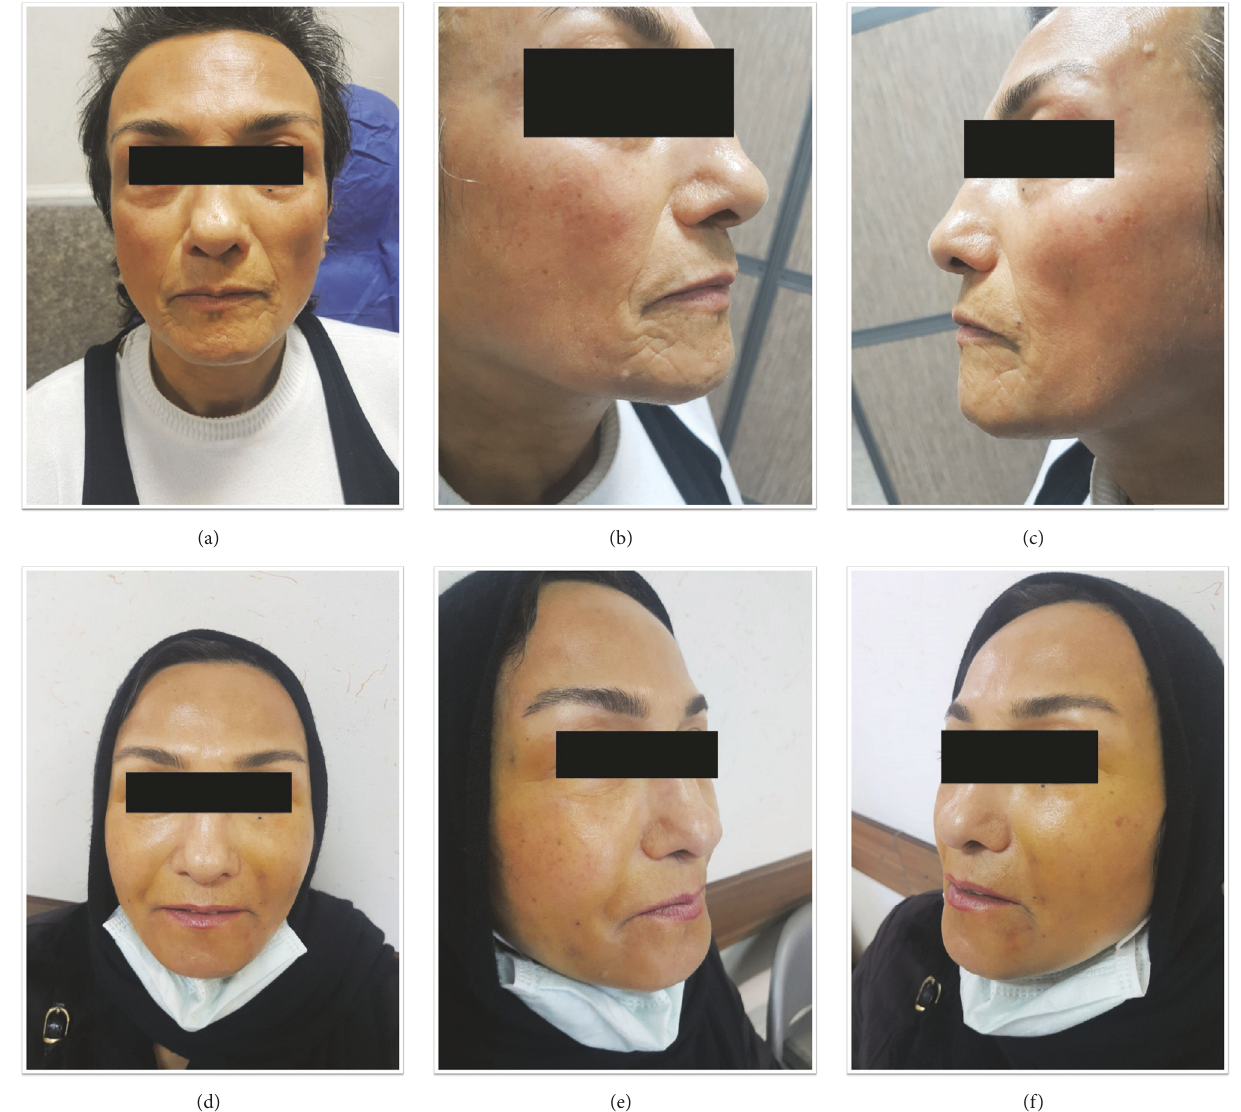
Figure 3: Aesthetic improvement after autologous fat transfer, baseline (a, b, c) and 3 months after autologous fat transfer (d, e, f).